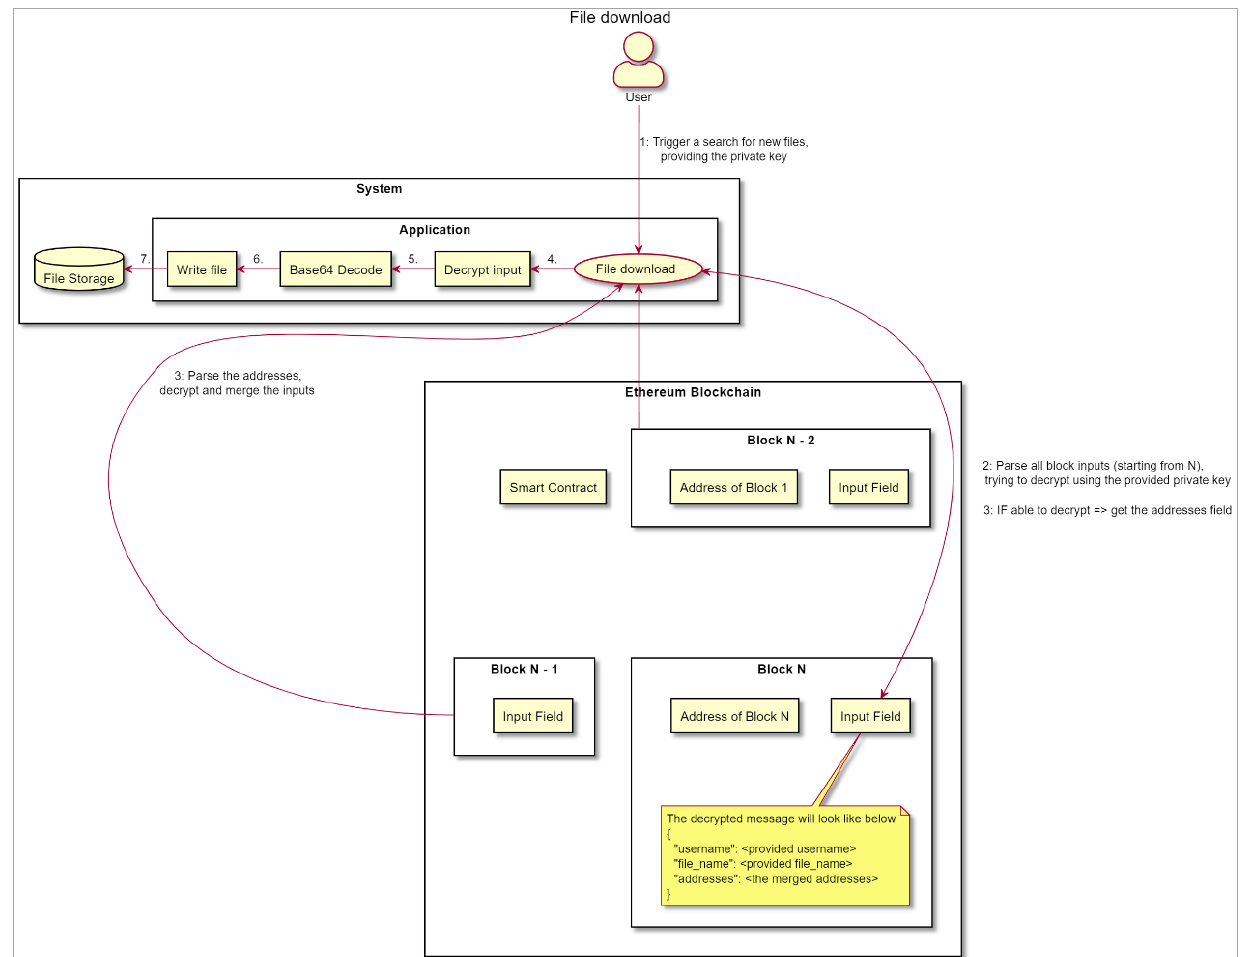
Figure 6. Flowchart of “Downloading a